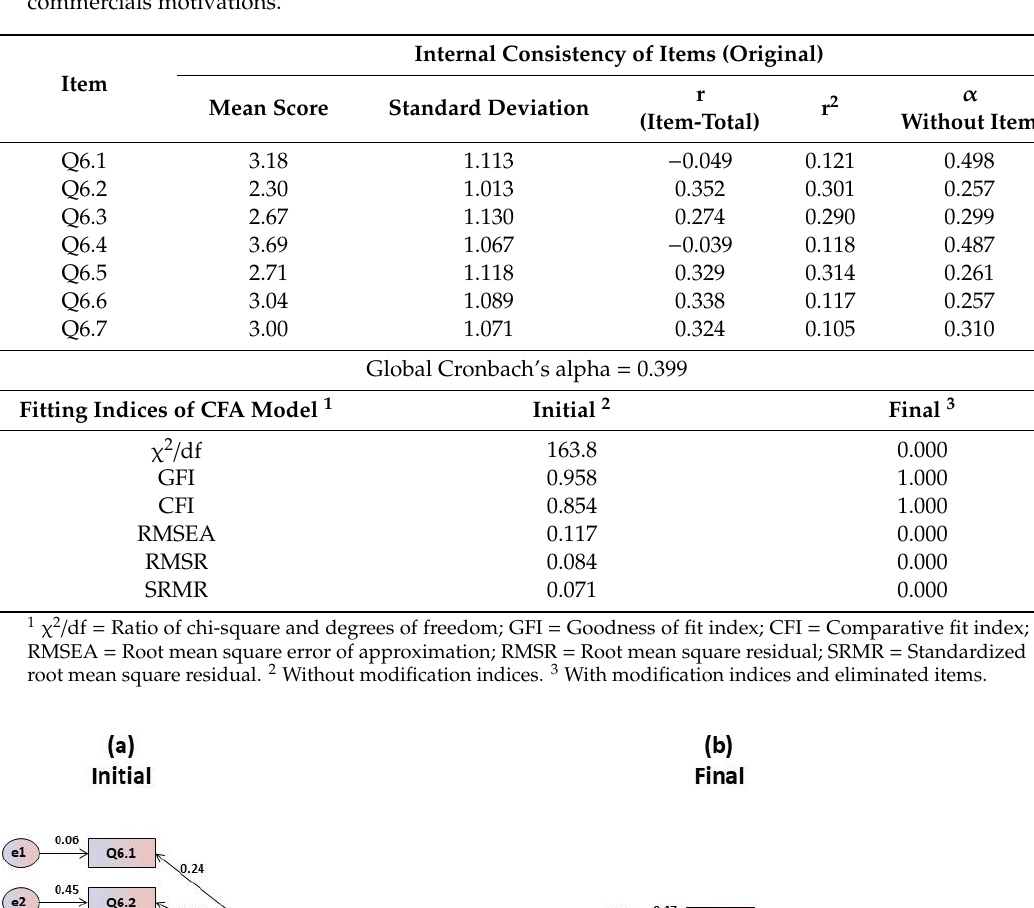
Table 6. Statistics for the unidimensional model of the scale about marketing and commercials motivations.